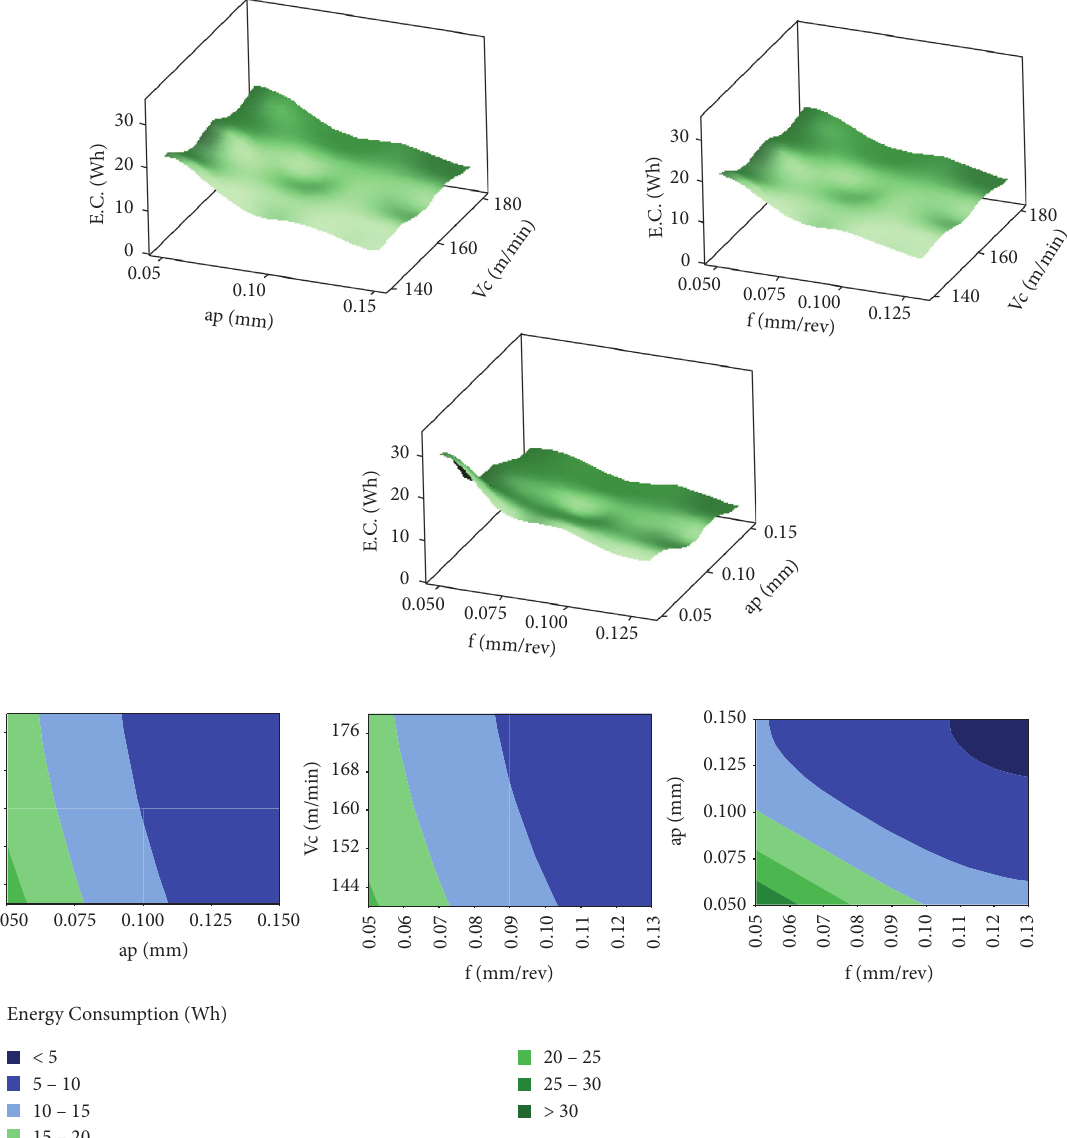
Figure 7: 3D surface plots and contour plots based on cutting parameters for energy consumption value.